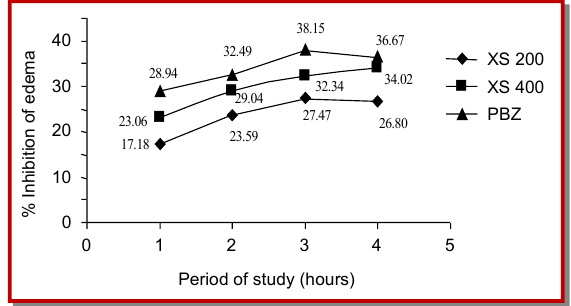
Figure 1: Anti-inflammatory activity of Xeromphis spinosa crude extract in carrageenin-induced rat paw edema model